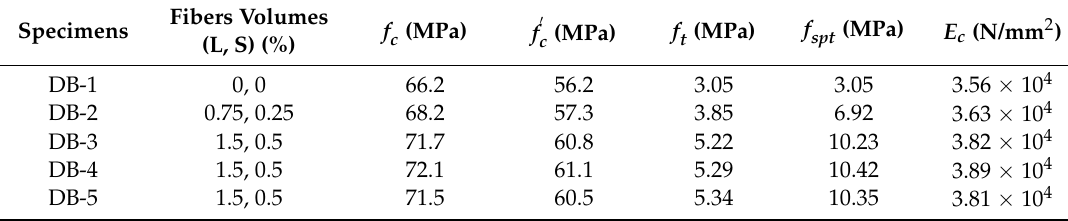
Table 4. Material properties of concrete.